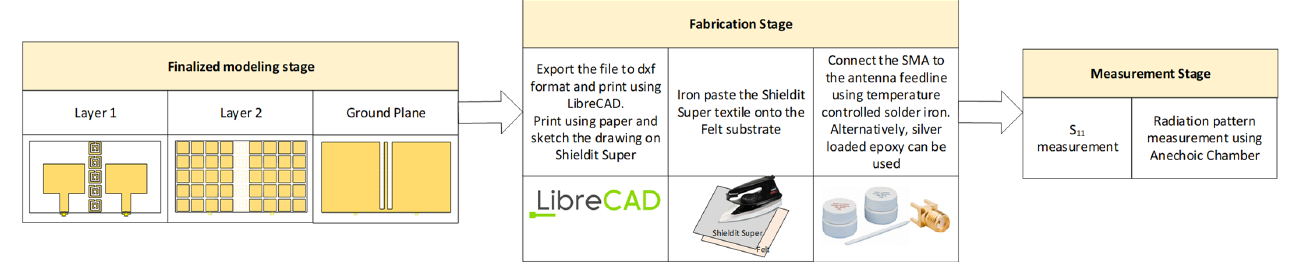
Figure 6. Fabrication process of the meta-wearable textile antenna in this study.